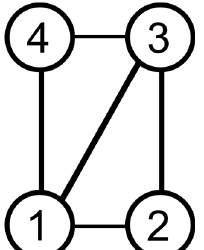
Figure 1. Exemplary simple graph having four nodes and five edges.